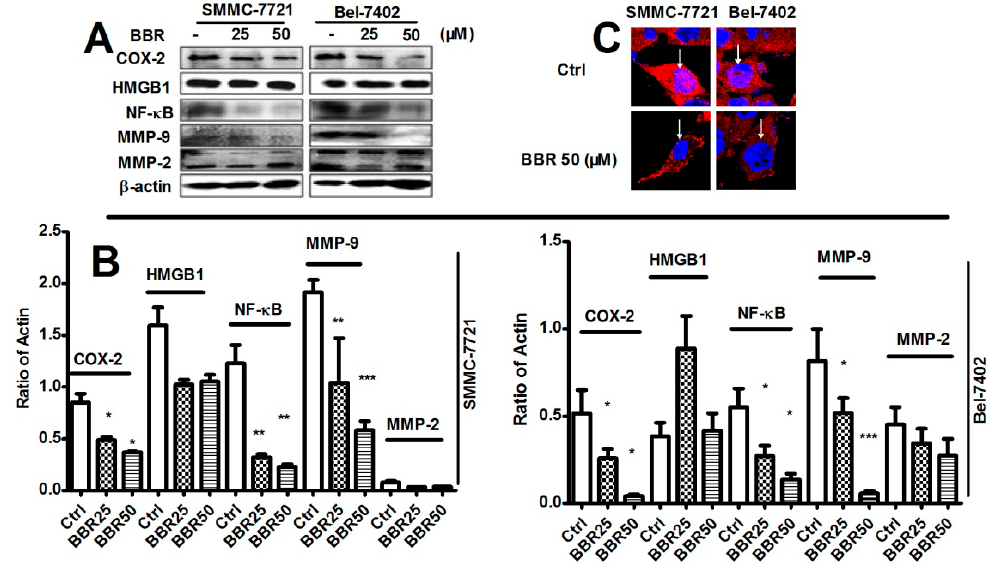
Figure 5. Inhibition of Cyclooxygenase-2 (COX-2), NF- κ B and matrix metalloproteinase (MMP)-9 in BBR-treated HCC cells. SMMC-7721 and Bel-7402 cells were treated with BBR for 6 h. Proteins were collected. ( A , B ) expression of COX-2, HMGB1, NF- κ B, MMP-9 and MMP-2 were analyzed by western blot. β -actin was used as internal standard. * p < 0.05 ( vs. the control group); ** p < 0.01 ( vs. the control group); *** p < 0.001( vs. the control group); ( C ) 50 μ M of BBR-treated cells were incubated with NF- κ B primary antibody, secondary antibody conjugated with Alexa Flour-568 (red dye). Nuclei were stained by DAPI (blue dye). NF- κ B in both nuclei and cytoplasm was observed by confocal microscope. The results show that compared with the control group, the level of NF- κ B (red) in nuclei (blue) was reduced (white arrow).